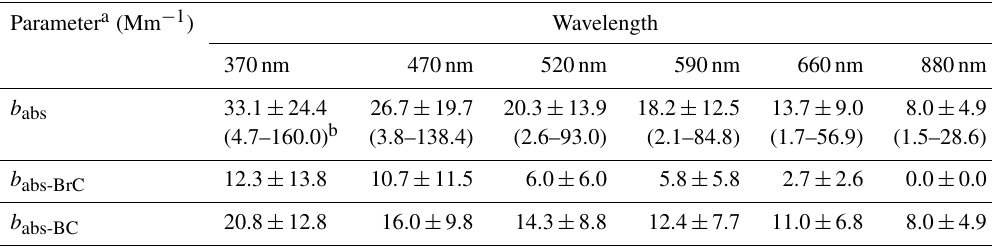
Table 1. Submicron aerosol light absorption coefficient ( b abs ) contributed by BrC ( b abs-BrC ) and BC ( b abs-BC ) at Gaomeigu during the sampling period (14 to 31 March 2018).